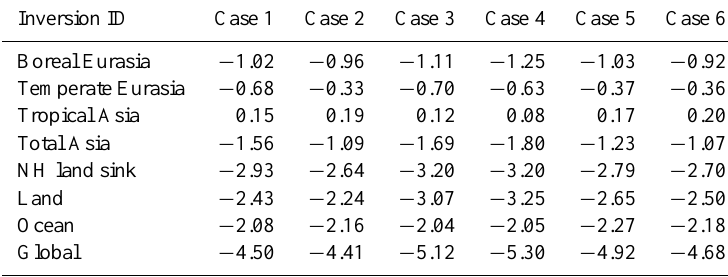
Table 3. Results of the sensitivity experiments conducted in this study (units ofPgCyr − 1 ) ∗ .